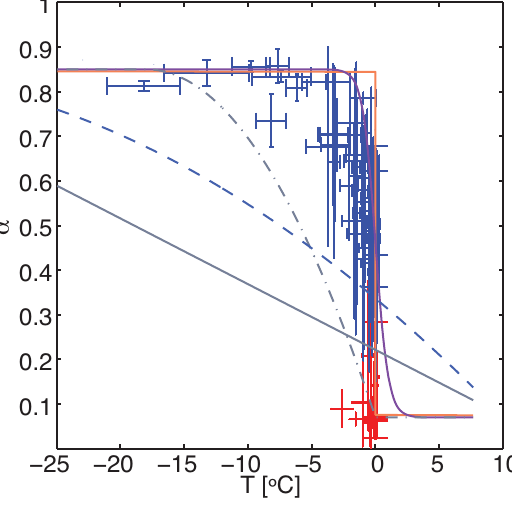
Fig. 3. Observed and parameterized temperature dependence in sur- face albedo: The data points correspond to daily average albedo along a transect in the SHEBA experiment versus daily average temperature (Perovich’s ice SHEBA data (blue w/ error bars); Paul- son’s lead SHEBA data (red w/ error bars); and Andreas et al.’s temperature SHEBA data). The albedo parameterizations were adjusted to fit the data for cold ice ( α I = 0 . 85) and open water ( α W = 0 . 07). The parameterizations from conceptual models in the literature include a linear temperature dependence on a wide interval (ALW, grey line) suggested by Sellers (1969), a smooth step like temperature dependence (AST, purple line) suggested by Eisenman and Wettlaufer (2009), and a smooth step like energy de- pendence (Eq. 3, ASE, orange line) suggested by M¨uller-Stoffels and Wackerbauer (2011a). For illustration of intermediate param- eterizations a quadratic parameterization over Seller’s wide tem- perature interval ( − 43 ◦ C ≤ T ≤ 10 ◦ C, AQW, blue dashed line), and a quadratic parameterization over a narrow temperature interval ( − 18 ◦ C ≤ T ≤ 0 ◦ C, AQN, grey dash-dotted line) are